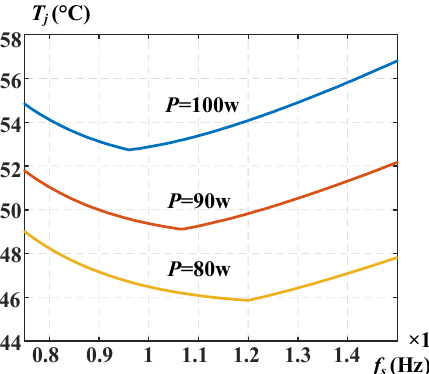
Figure 6. T j –f s curve with different load power.